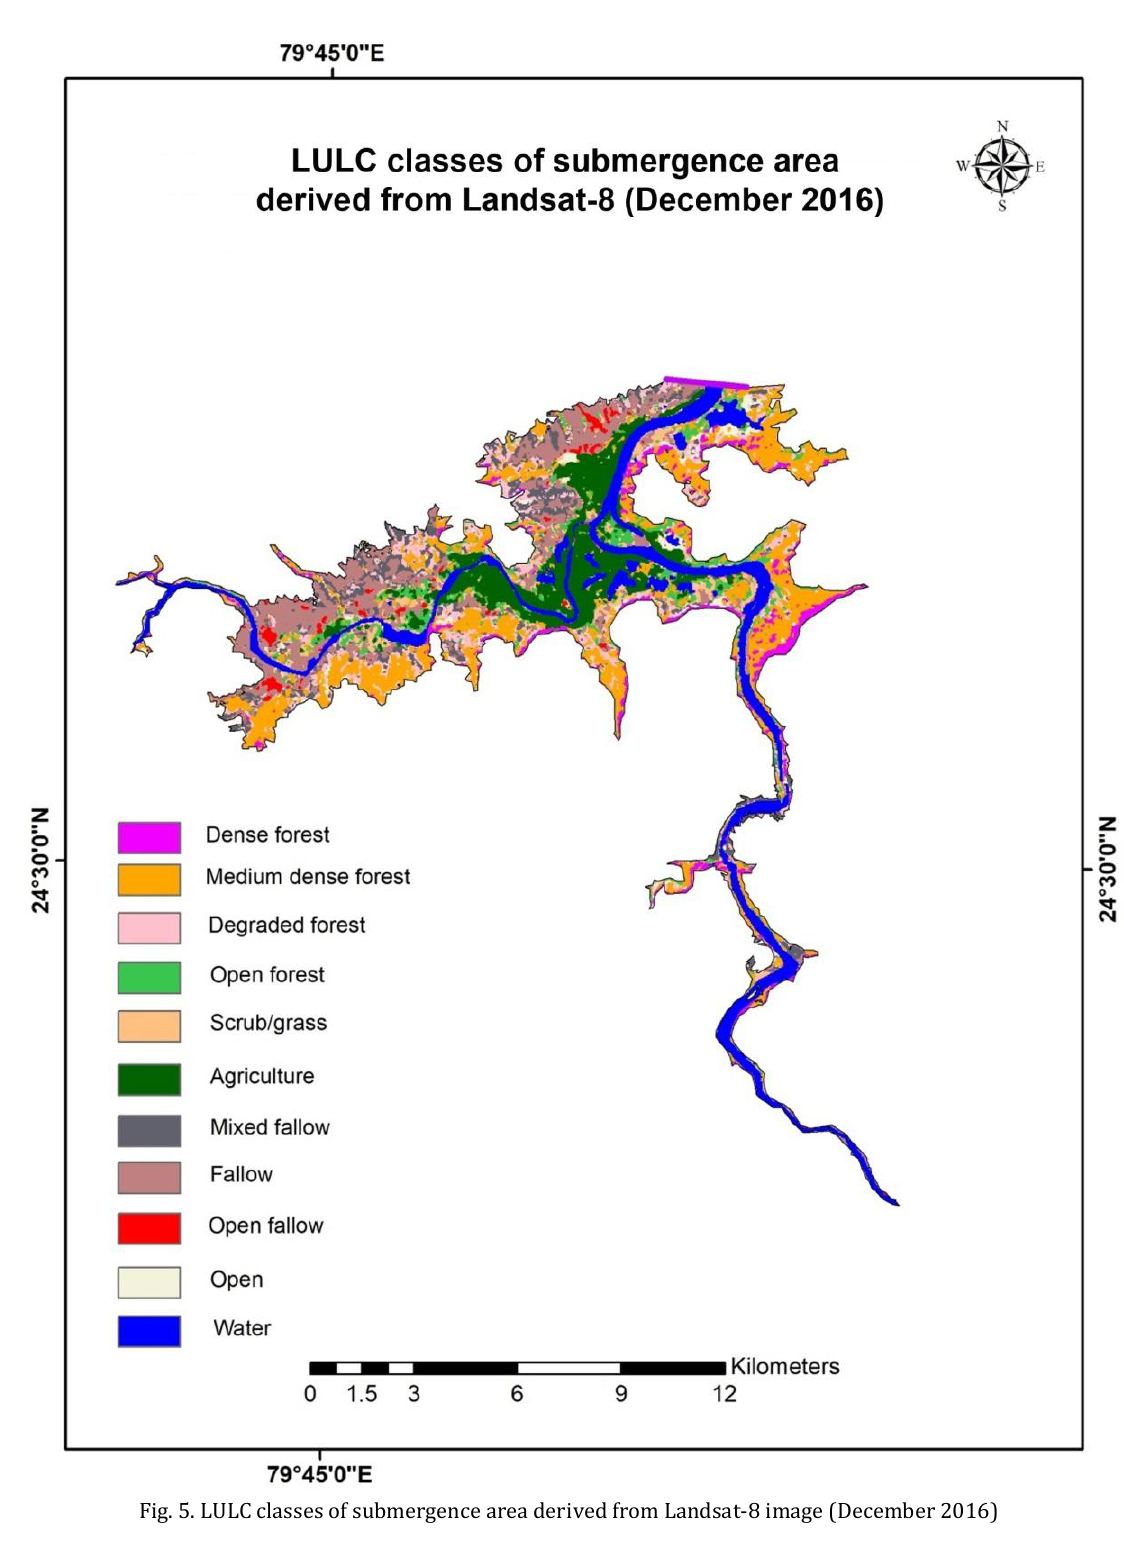
Fig. 5. LULC classes of submergence area derived from Landsat-8 image (December